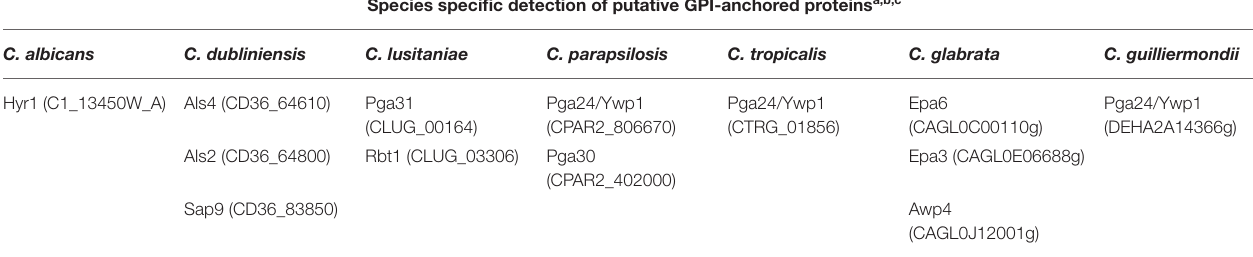
TABLE 2 | Candida species-specific detection of cell wall GPI-anchored proteins by LC/MS/MS proteomics. Species specific detection of putative GPI-anchored proteins a,b,c